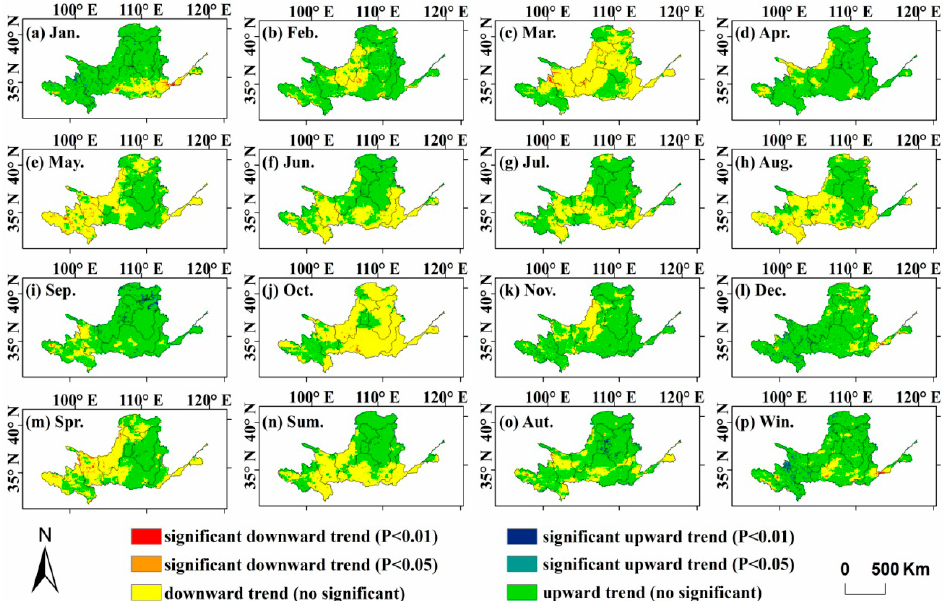
Figure 8. Monthly and seasonal trends of Gridded Standardized Precipitation Evapotranspiration Index (GSPEI) in the Yellow River basin (YRB) during 1998–2016 by using the Modified Mann–Kendall (MMK) trend test method.